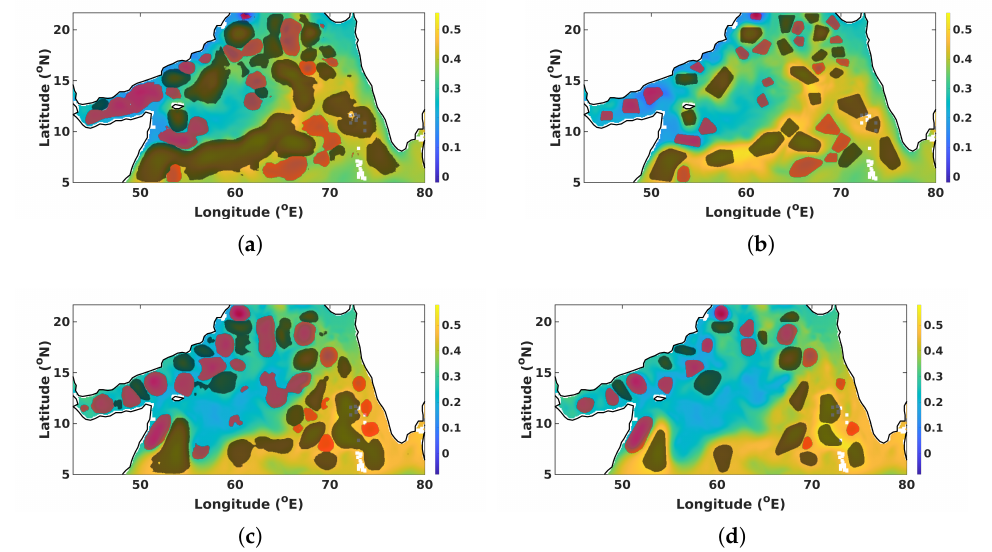
Figure 4. Ground-truth and predicted segmentation masks for the U-Net–PSPnet deep neural network using only the SSH data as input. The segmentation maps are superposed on the SSH data only to show the input to the network alongside the output masks. The plots demonstrate that the network captures the labeled eddies with smoother boundaries than those in the ground-truth plots but lumps some labels together. Here, the cyclonic eddies are colored red and the anticyclonic eddies are colored black. The color bars at the sides of each panel indicate the SSH values in meters; ( a ) Prediction— Sample 1; ( b ) Ground Truth—Sample 1; ( c ) Prediction—Sample 2; ( d ) Ground Truth—Sample